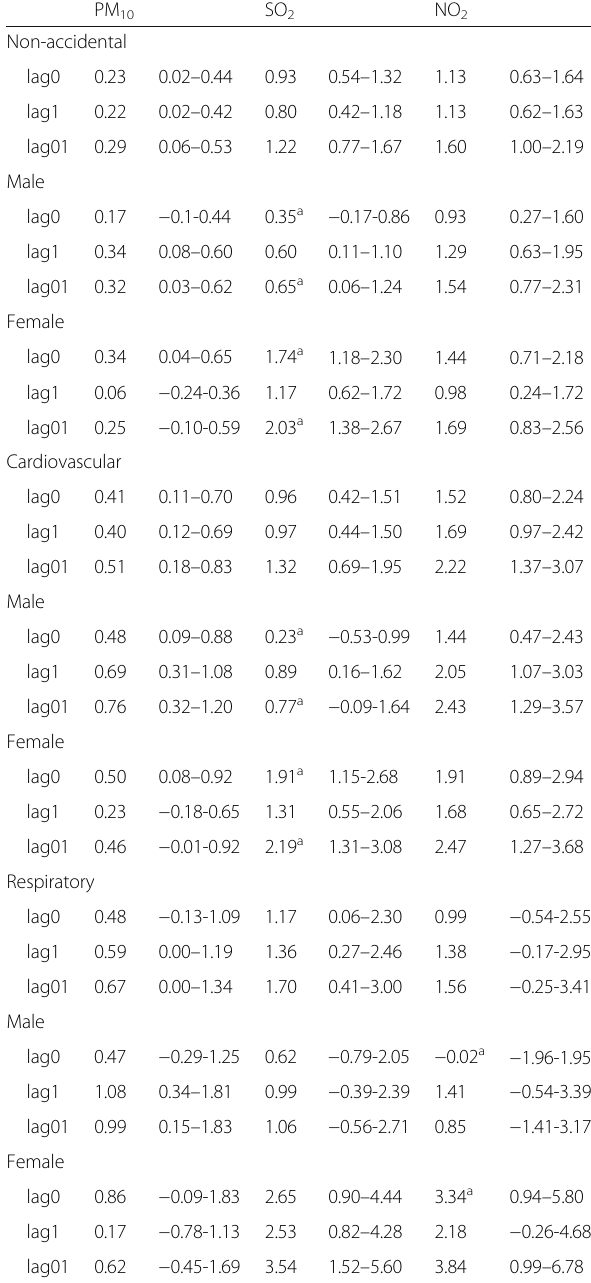
Table 3 Percent increase (mean and 95% confidence interval) in daily cause-specific mortality associated with a 10- μ g/m 3 increase in air pollutants concentrations by sex at different